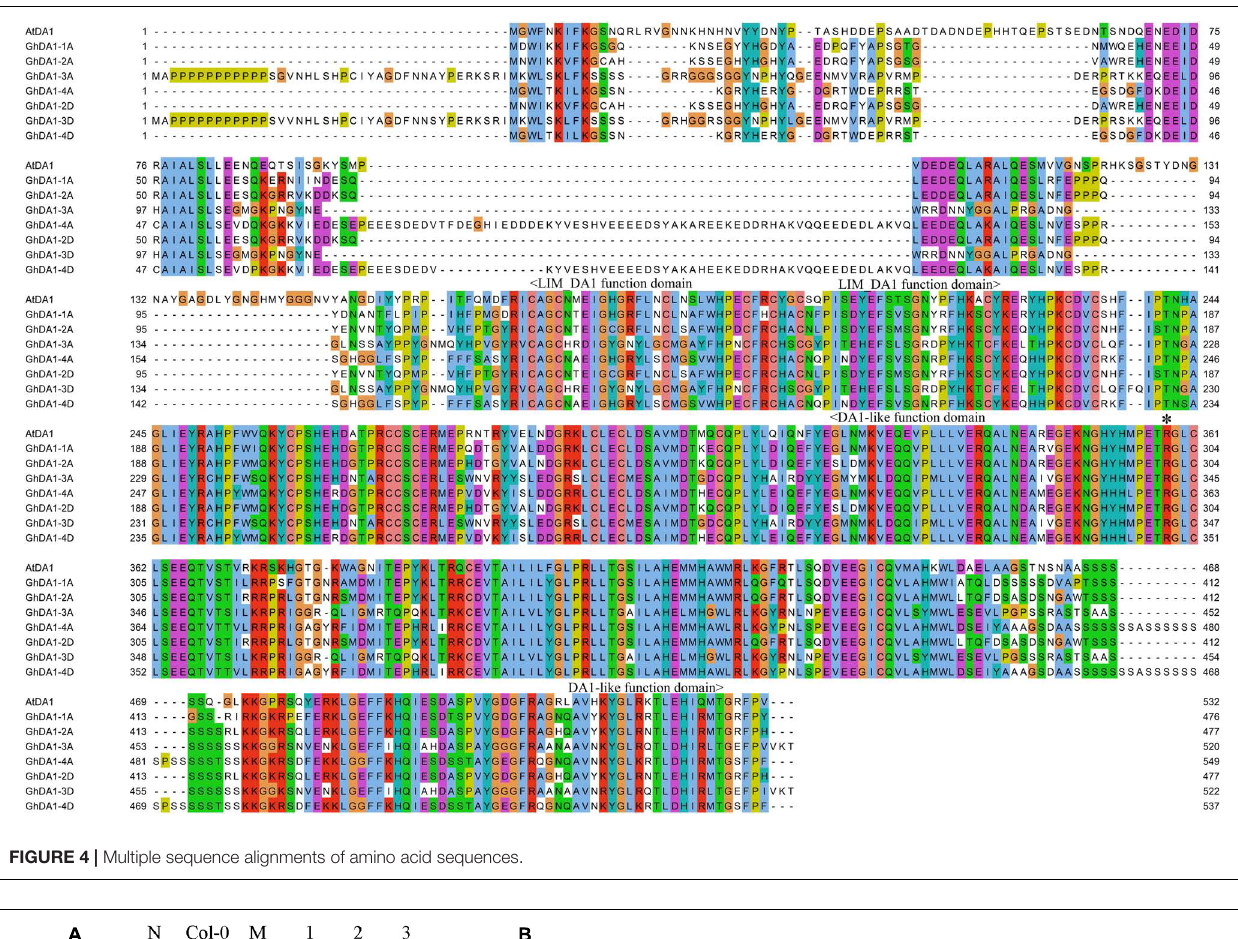
FIGURE 4 | Multiple sequence alignments of amino acid sequences.